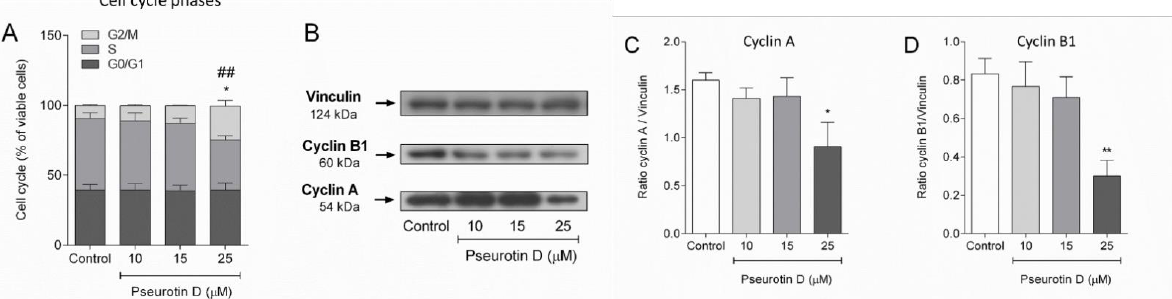
Figure 3. The effect of pseurotin D (10 – 50 µM) on the cell cycle. The cell cycle was analyzed by Clic-iT EdU kit ( A ). ( B ) shows a representative Western blot of the expression of cyclin B1, A, and vinculin by MEC-1 after 24 h of treatment. The analysis of optical density expressed as a ratio of the optical density of cyclins to the optical density of vinculin (equal loading control) is depicted in ( C ) for cyclin A and panel ( D ) for cyclin B1. Data were expressed as the mean ± SEM ( n = 3) and analyzed by ANOVA combined with Dunnett’s test (** p < 0.01 and * p < 0.05). In ( A ) * represents the statistical analysis of the S phase and # represents the statistical analysis of the G2/M